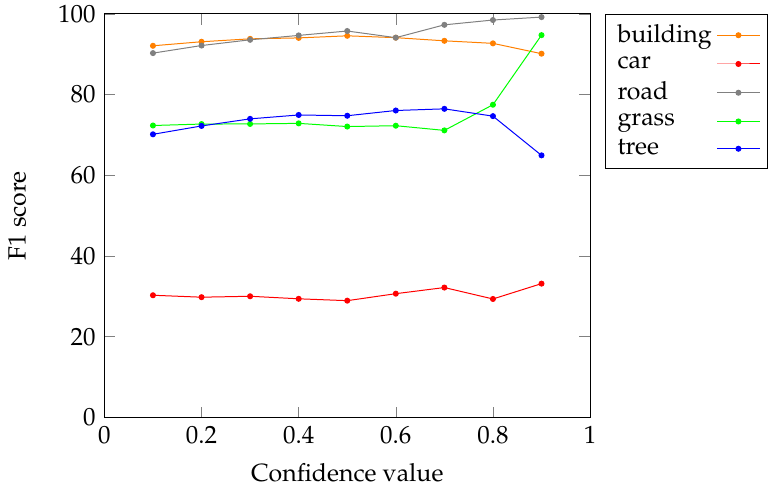
Figure 7. Accuracy of the super-pixels (F1 score; y -axis) in each class according to the confidence value threshold ( x -axis).